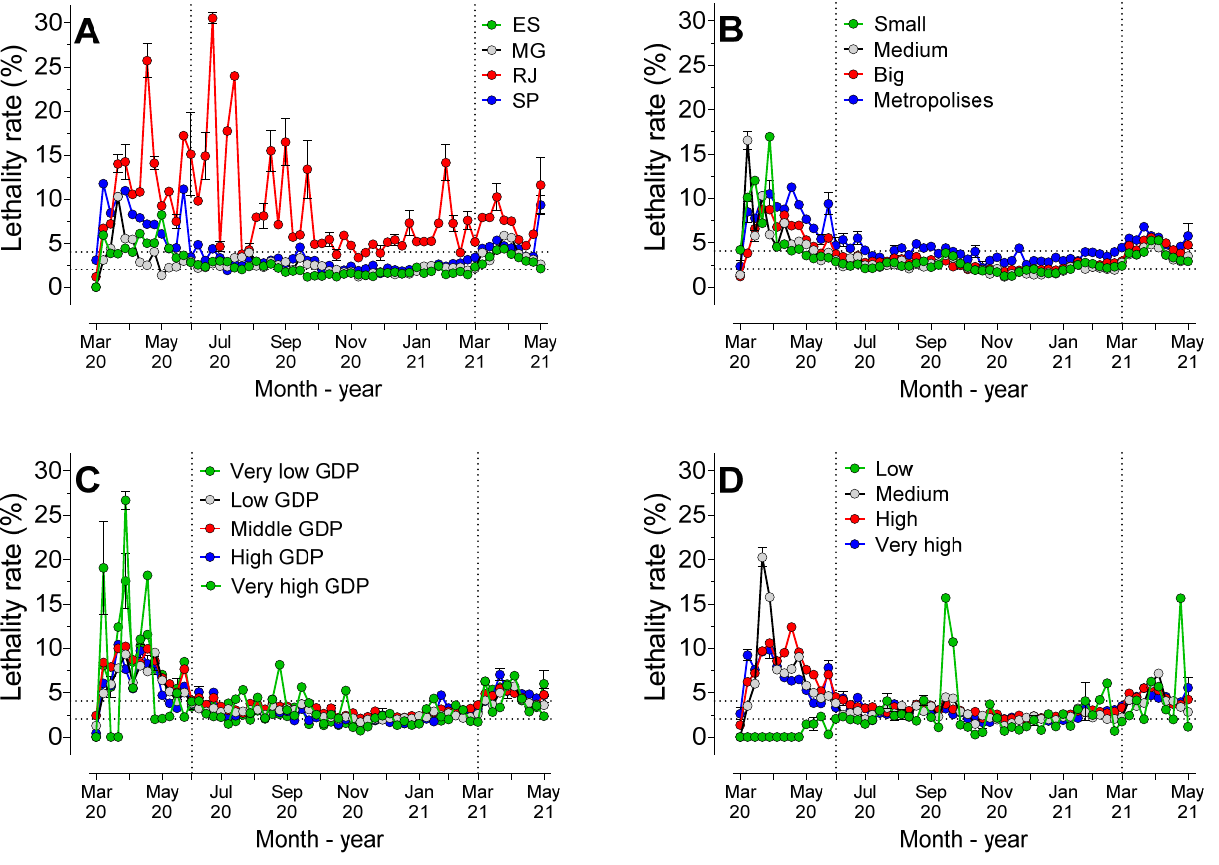
Figure 6. Mean lethality rate (95%CI) considering the following: ( A ) states; ( B ) population size; ( C ) gross domestic product (GDP); and ( D ) Municipal Human Development Index (HDI-M), over the course of 62 weeks of the pandemic. Legend ( A )—ES = Espírito Santo; MG = Minas Gerais; SP = São Paulo; and RJ = Rio de Janeiro. Legend ( B )—small cities (under 50,000 inhabitants); medium cities (50,000 to 100,000 inhabitants); big cities (100,000 to 500,000 inhabitants); and metropolises (over 500,000 inhabitants). Legend ( C )—very low GDP (lower than BRL 10,000); low GDP (BRL 10,001 to BRL 30,000); middle GDP (BRL 30,001 to 60,000); high GDP (BRL 60,001 to 100,000); and very high GDP (higher than BRL 100,000). Legend ( D )—very low HDI-M (0 to 0.499); low HDI-M (0.500 to 0.599); medium HDI-M (0.600 to 0.699); high HDI-M (0.700 to 0.799); and very high HDI-M (0.800 to 1.0).